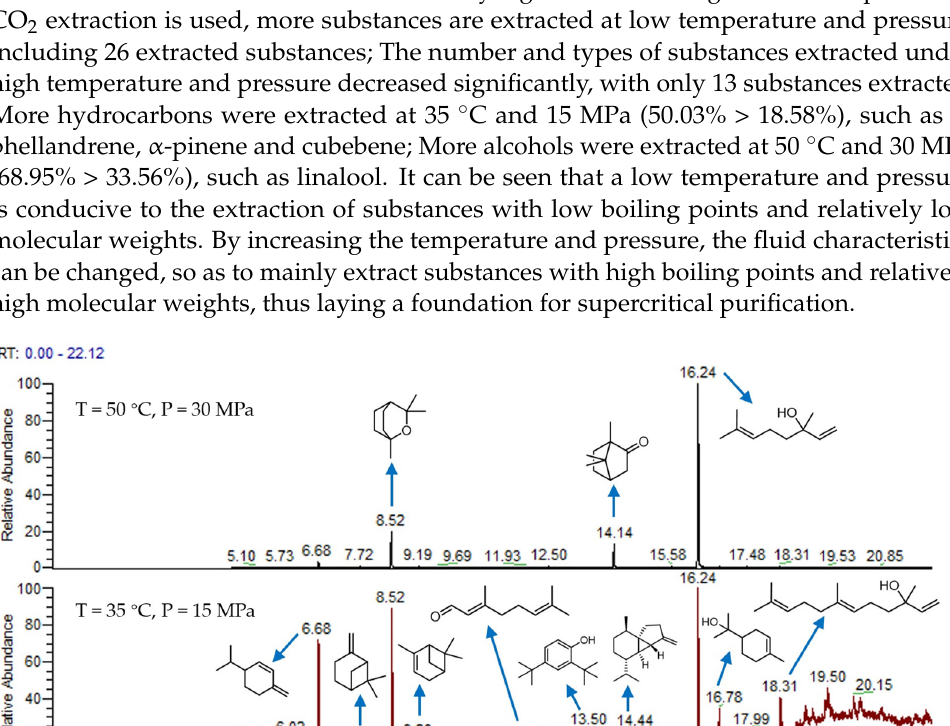
Table 3. Components and peak area percentages of essential oils under different conditions and methods.